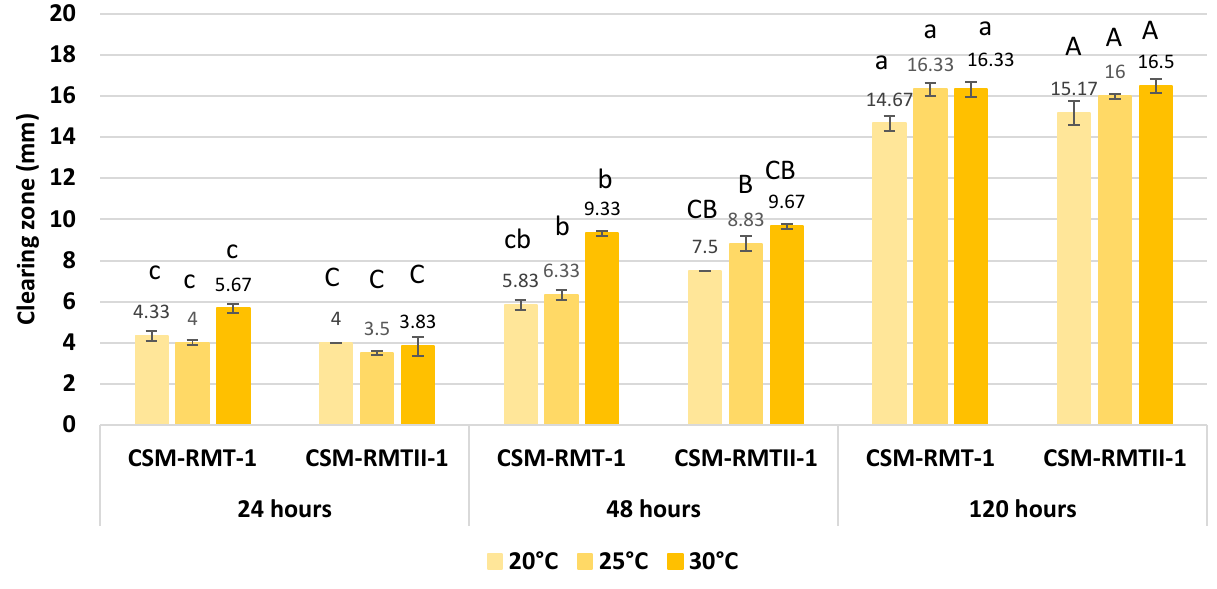
Figure 3. Proteolytic activities of S. marcescens CSM-RMT-1 and CSM-RMT-II-1 strains after 24, 48 and 120 h of incubation at three different (20, 25 and 30 ◦ C) temperatures. Sizes of clearing zones are mean values of three parallel measurements. The bars indicate the standard deviation of three replicates of the experiment. Different upper-case letters between the incubation times indicate a significant difference between the clearing zone within the same strain according to Games–Howell post hoc tests ( α = 0.05). Table 4. Statistical results of protease activity in the case of S. marcescens CSM-RMT-1 and S. marcescens